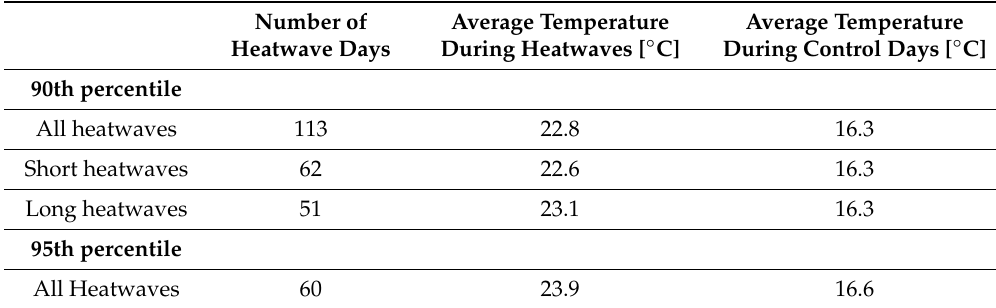
Table 3 shows the number of heatwave days and mean daily temperature during heatwave and non-heatwave days. Table 3. Number of heatwave days and mean temperature during heatwave and non-heatwave days during summer months (June–August) in the Helsinki metropolitan area, Finland,